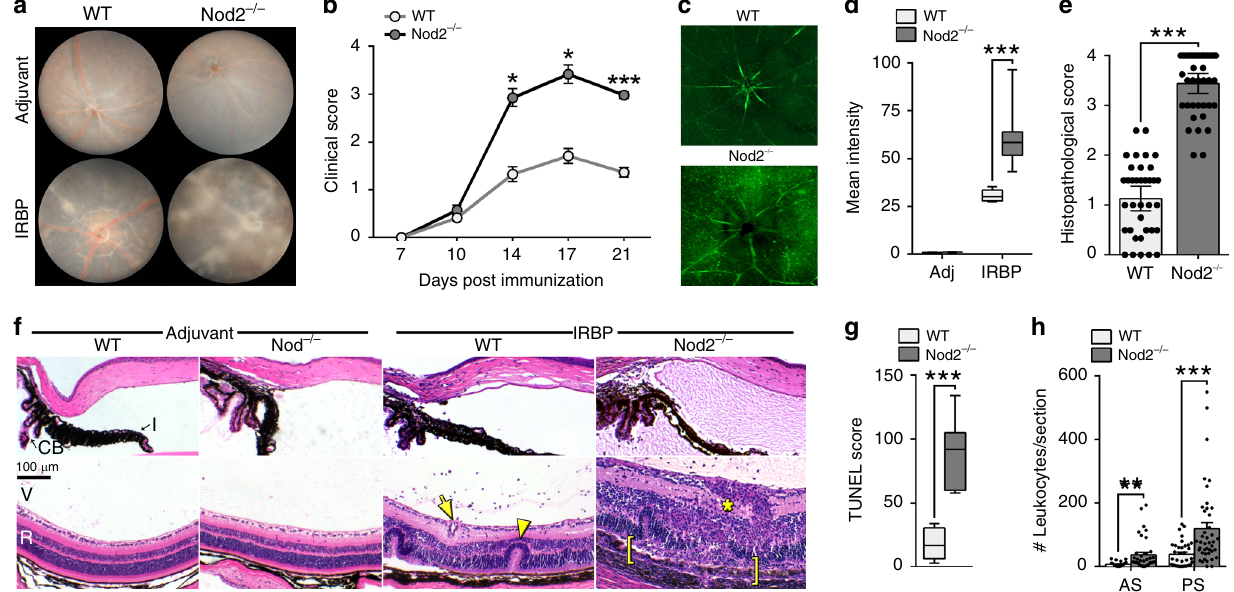
Fig. 1 Nod2 plays an unexpected protective role in uveitis. Six to ten week old WT and Nod2 − / − mice were immunized and assessed weekly thereafter for disease. a Representative fundus images of the posterior pole at day 21 post-immunization, and ( b ) clinical grading of uveitis based on fundoscopy. Data in b is combined from 6 independent experiments with an n = 12 mice/group for day 7 and day 17, n = 24 (WT) and 19 (Nod2 − / − ) mice/group for day 10, n = 44 (WT) and 28 (Nod2 − / − ) mice/group for day 14, and n = 56 (WT) and 54 (Nod2 − / − ) day 21; * p = 0.0177 (14 day), * p = 0.0093 (day 17), and *** p < 0.0001 (day 21). c Representative epi fl uorescence images and ( d ) quanti fi cation of blood-retinal barrier integrity 10 days post-immunization. Data is combined from 2 independent experiments where n = 9 (WT adjuvant and Nod2 − / − IRBP) or 8 (WT IRBP and Nod2 − / − adjuvant) mice; *** p < 0.0001. e Uveitis was scored by histopathology 21 days post-immunization. Data was combined from 6 independent experiments where n = 38 (WT) and 39 (Nod2 − / − ) mice; *** p < 0.0001. f Representative H&E-stained sections of the anterior segment (top) and posterior segment (bottom) of eyes day 21 post immunization. Pathological features indicated: retinal folding (arrowhead), granulomatous formation (asterisk), vasculitis (arrow), and severe photoreceptor damage (bracket). I, iris; CB, ciliary body; V, vitreous; R, retina. g Apoptosis within the retina (14 days post immunization) was determined